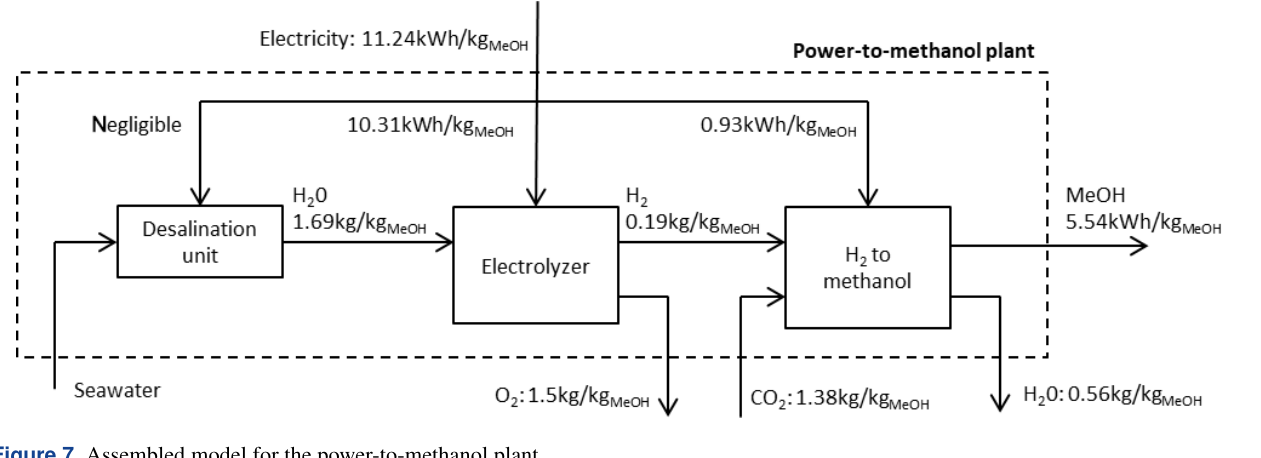
Figure 7. Assembled model for the power-to-methanol plant.